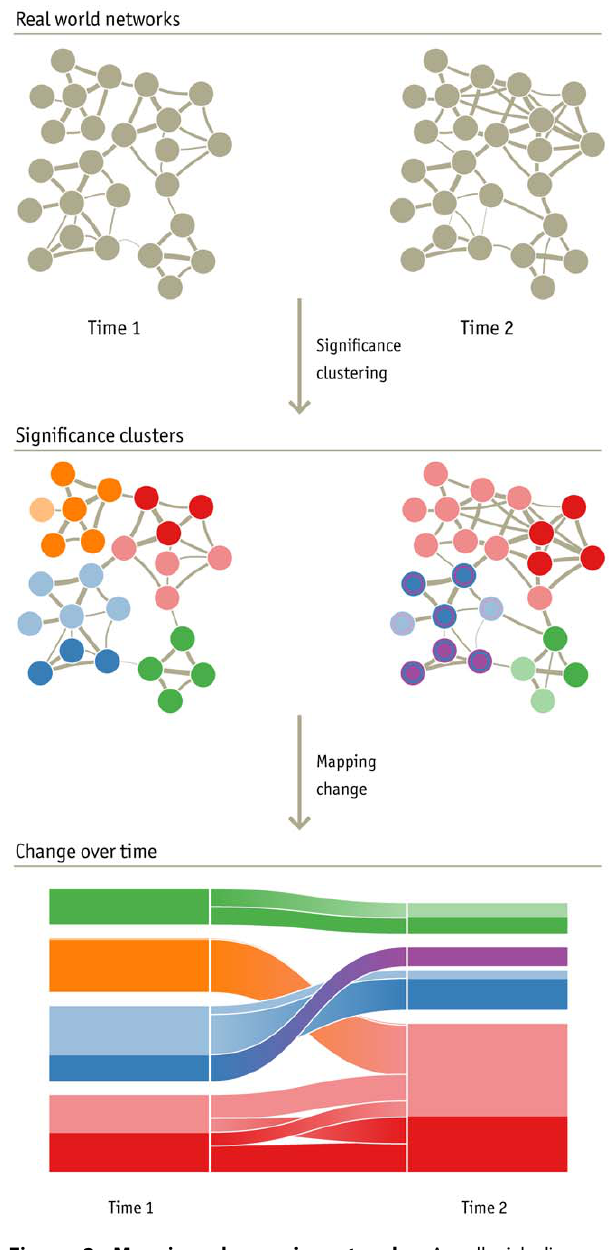
Figure 2. Mapping change in networks. An alluvial diagram (bottom), with clusters ordered by size, reveals changes in network structures over time. Here the height of each block represents the volume of flow through the cluster, with significant subsets in darker color. The orange module merges with the red module, but the nodes are not clustered together in 95% of the bootstrap networks. The blue module splits, but the significant nodes in the blue and purple modules are clustered together in more than 5% of the bootstrap networks. With a 5% significance threshold, neither change is significant.